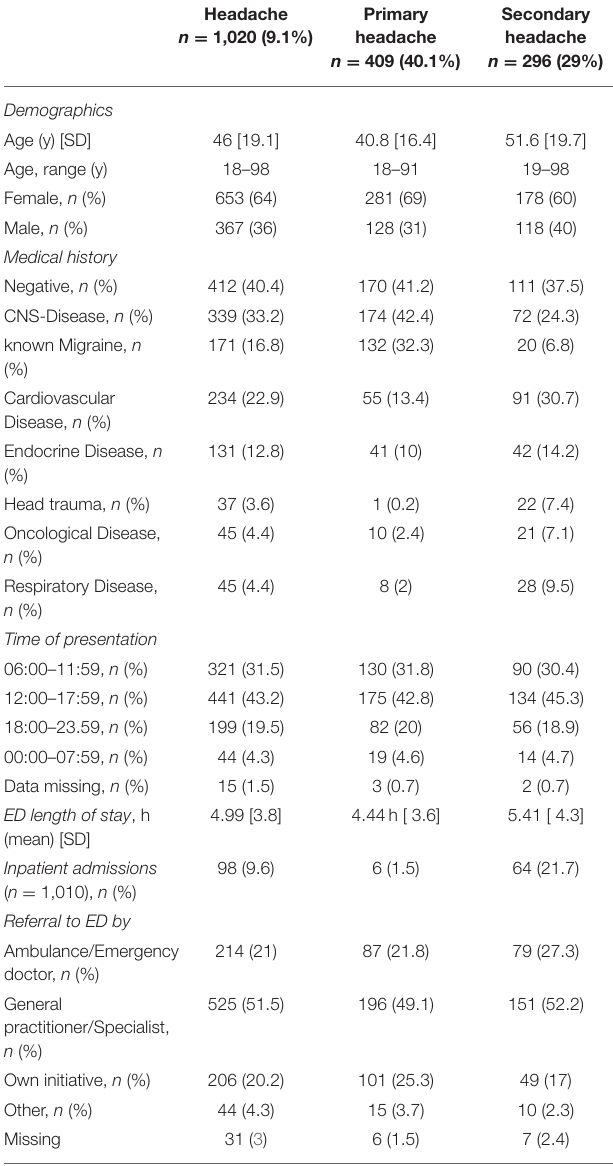
TABLE 1 | Demographics and characteristics of patients with headache as cardinal symptom in the